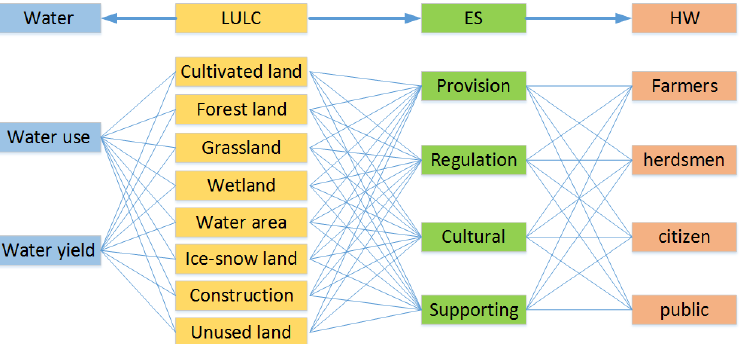
Figure 5. Multiple mapping relationship of W-LULC-ES-HW. Note: W is water use or water yield;